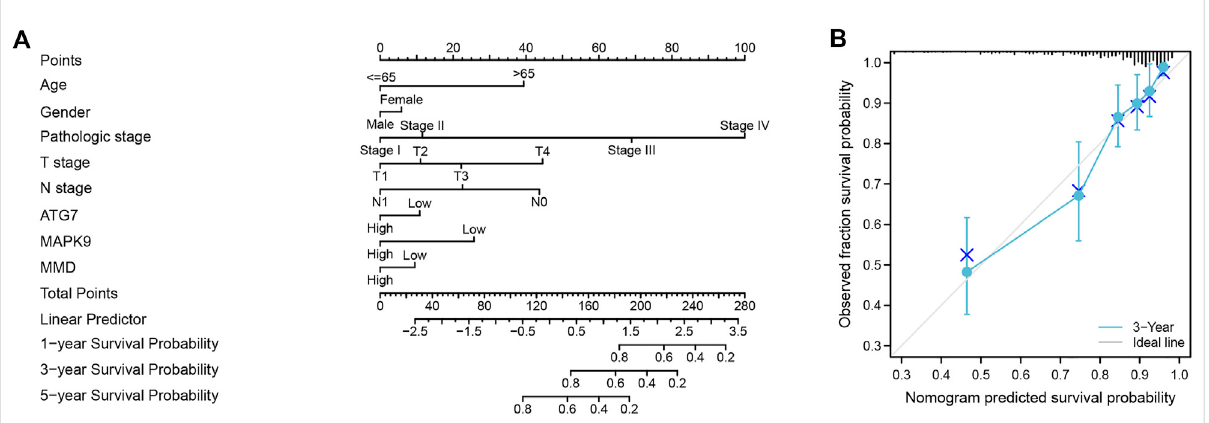
FIGURE 6 The ferroptosis-related prognostic nomogram and calibration curve. (A) A predictive ferroptosis-related prognostic nomogram predicted the 1-year, 3-years, and 5-years OS. (B) A calibration curve for the probability of 3-years